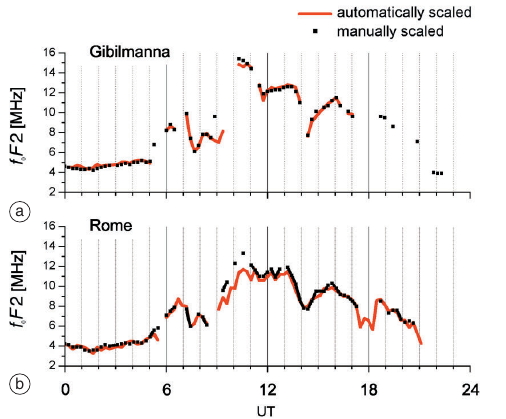
Fig. 6a,b. a) Plot of f 0 F 2 values, from the iono- grams recorded in Gibilmanna on 29 October 2003, obtained by a well experienced operator (black square) compared to the corresponding plot obtained by Autoscala (red line); b) plot of f 0 F 2 values, from the ionograms recorded in Rome on 29 October 2003, obtained by a well experienced operator (black square) compared to the corresponding plot obtained by ARTIST (red